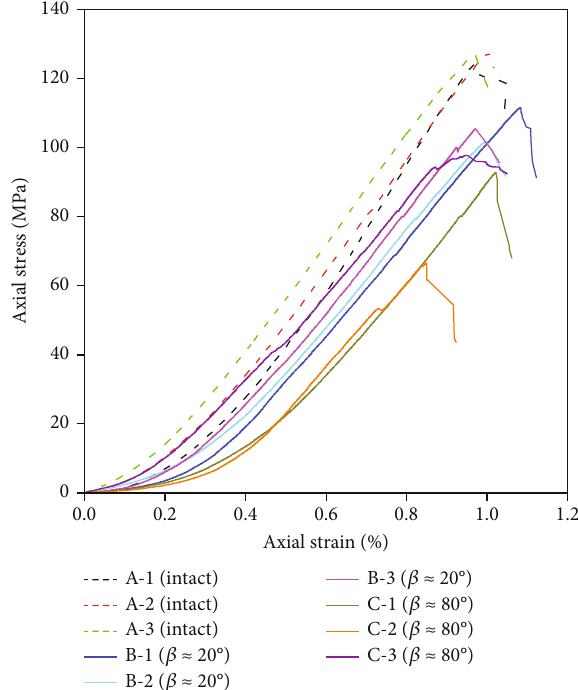
Figure 3: Axial stress-strain curves of selected samples under uniaxial